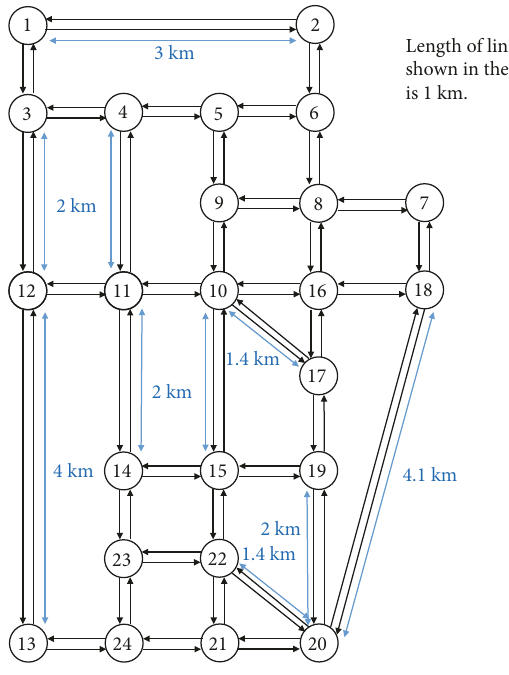
Figure 7: Sioux Falls